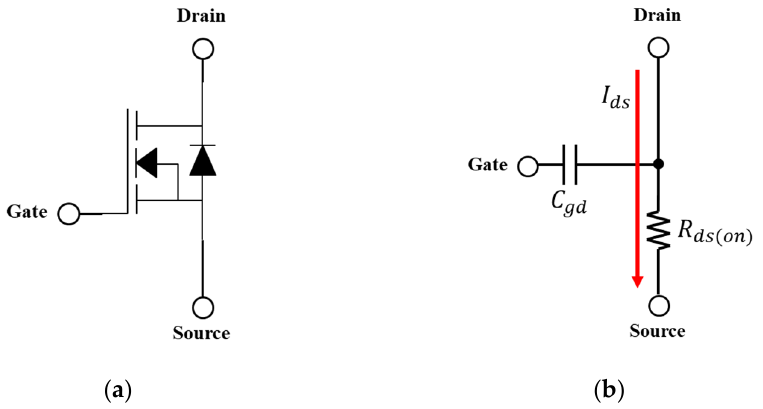
Figure 6. ( a ) Equivalent circuit of MOSFET; ( b ) Operation when MOSFET is on.